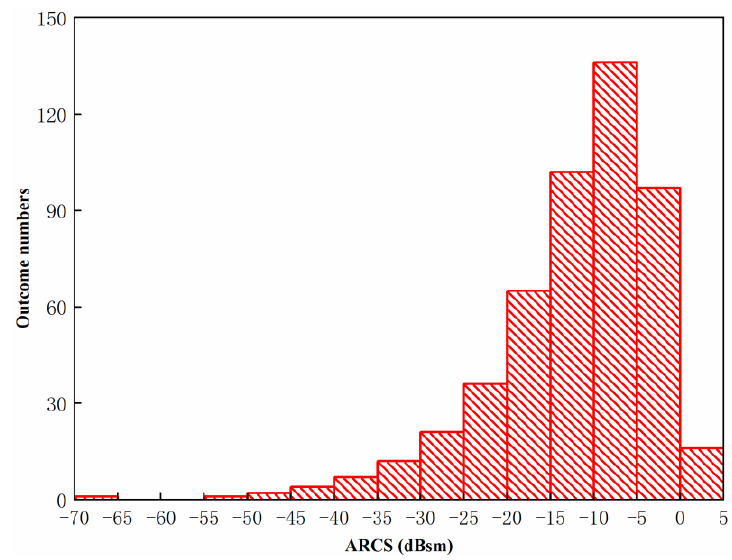
Figure 16. Statistic characteristics of ARCS obtained by the Gaussian distribution multi-radiators with 500 times random simulation. Table 2. The ARCS range, the outcome frequencies and the outcome rate at the Gaussian distribution. ARCS Range$$$